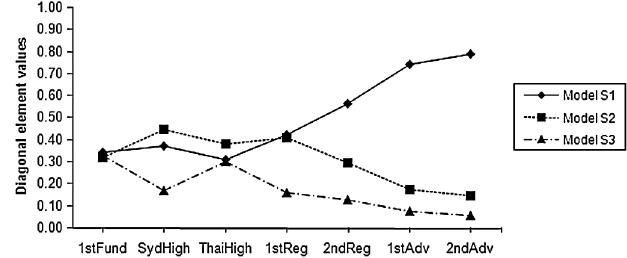
FIG. 3. Trend of the diagonal elements of all class model density matrices plotted against previous engagement with phys-